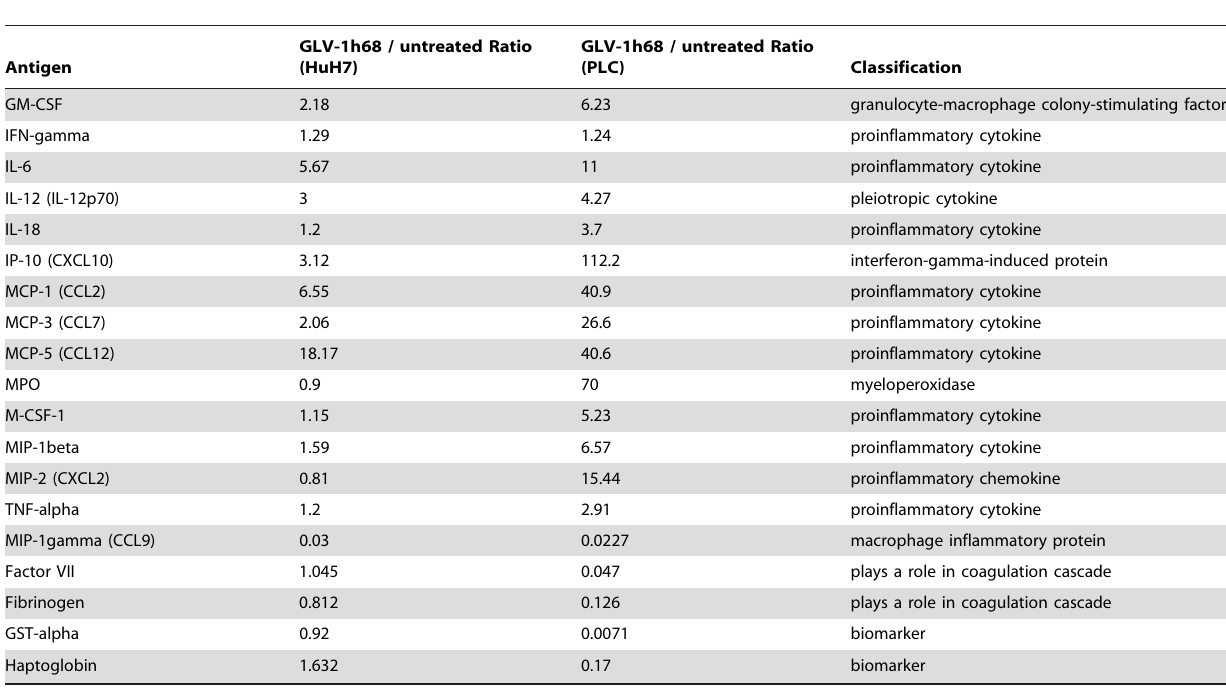
Table 2. Comparison of mouse immune-related protein antigen profiling in primary PLC and HuH7 tumors with or without GLV- 1h68 at day 10 after virus injection (n =3).